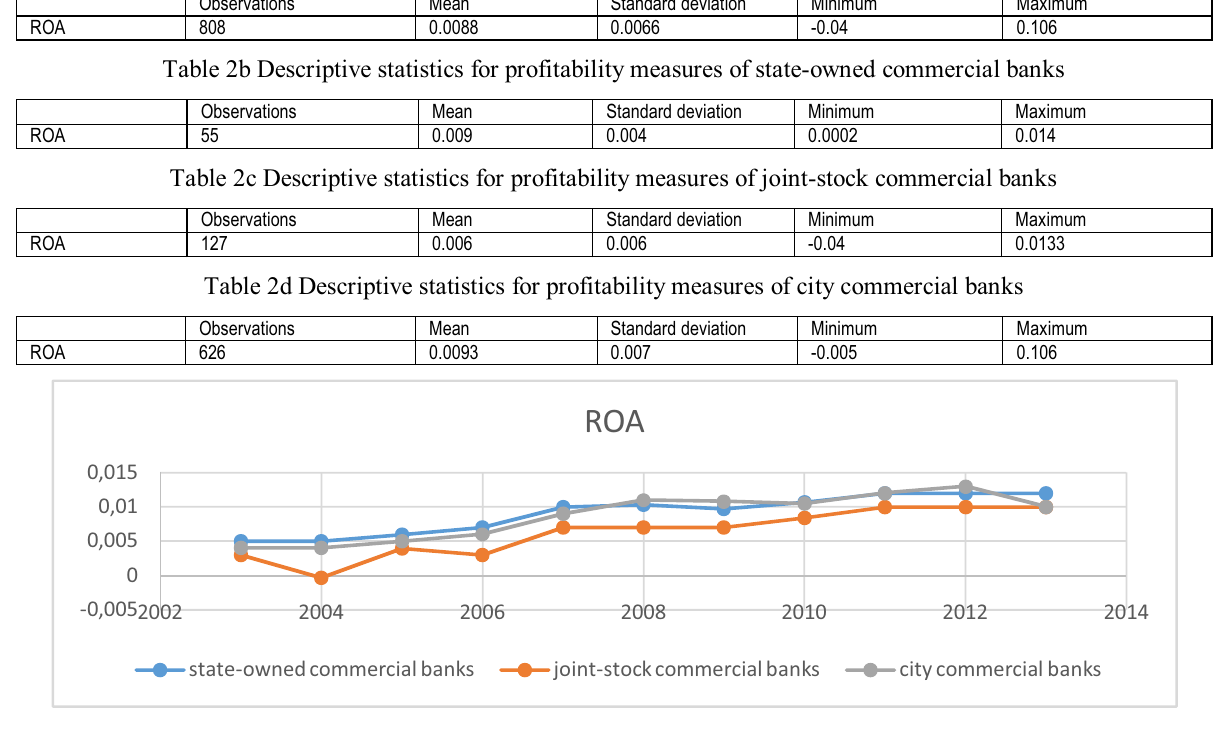
Table 2c Descriptive statistics for profitability measures of joint-stock commercial banks